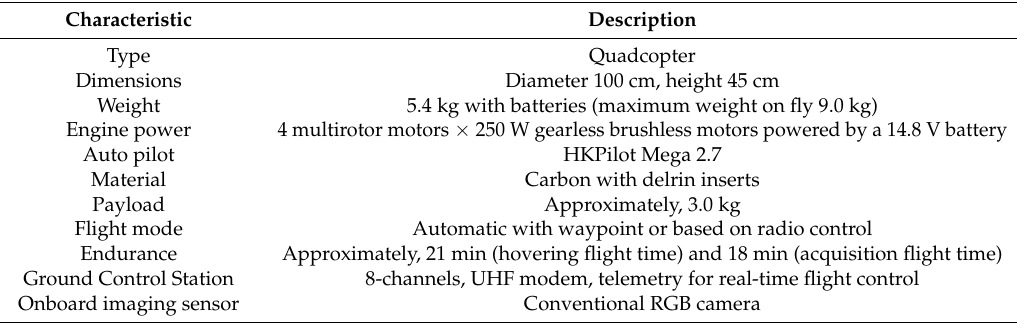
Table 1. Unmanned aerial vehicle (UAV)